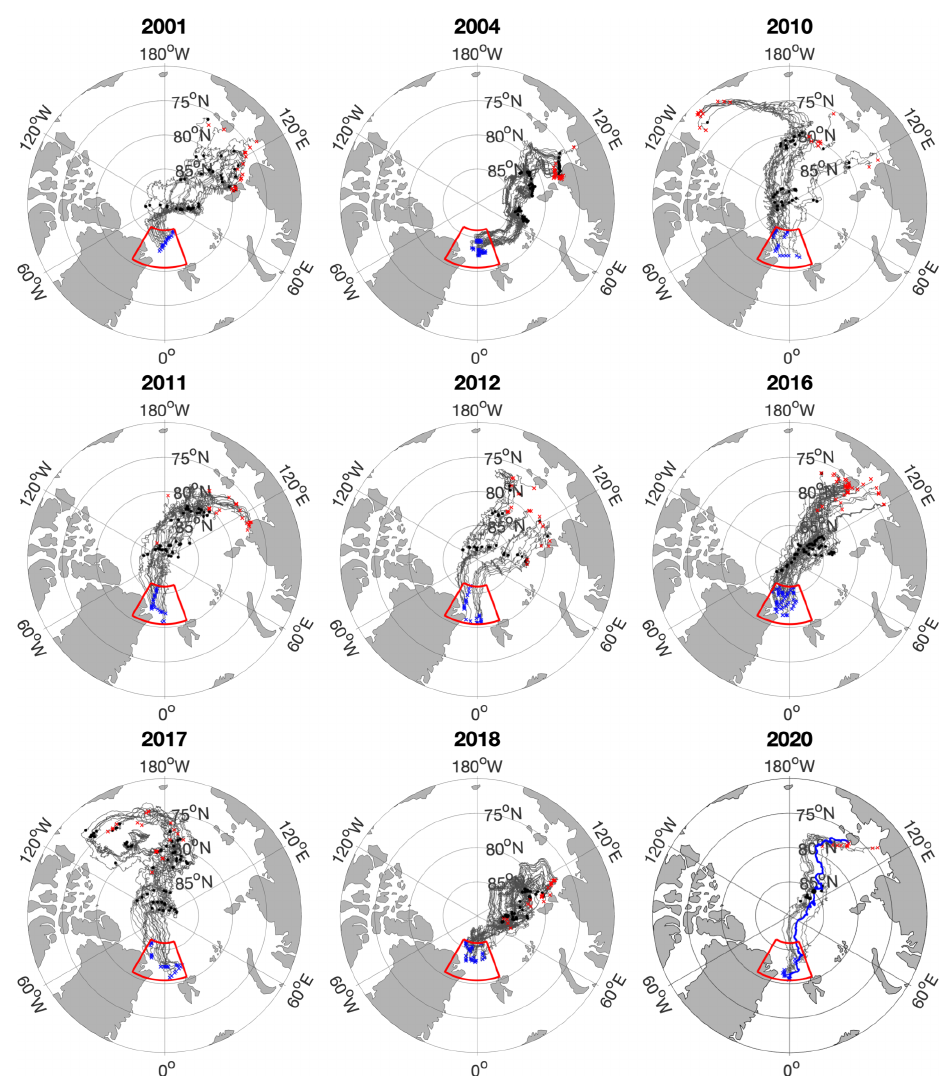
Figure 2. Drift trajectories of sea ice sampled in the AOI (enclosed area). Starting points of the backtracking (blue crosses) correspond to the positions where EM SIT measurements were conducted during summer (July–August–September) from 2001 to 2020. Backward tracking ended when sea ice concentration dropped to 25% or less, which is defined as the time and location of ice formation (red crosses). Black dots present sea ice position on 21 September of each year, when ice particles are considered to have survived the summer, becoming second-year or multi-year ice, respectively. The blue trajectory in 2020 represents the MOSAiC floe trajectory. The MOSAiC trajectory consists of GPS positions recorded during the drift (from 4 October 2019 until 21 July 2020) and backward tracked position (ICETrack) from the MOSAiC starting point (4 October 2019) to the position of ice formation (Krumpen et al.,